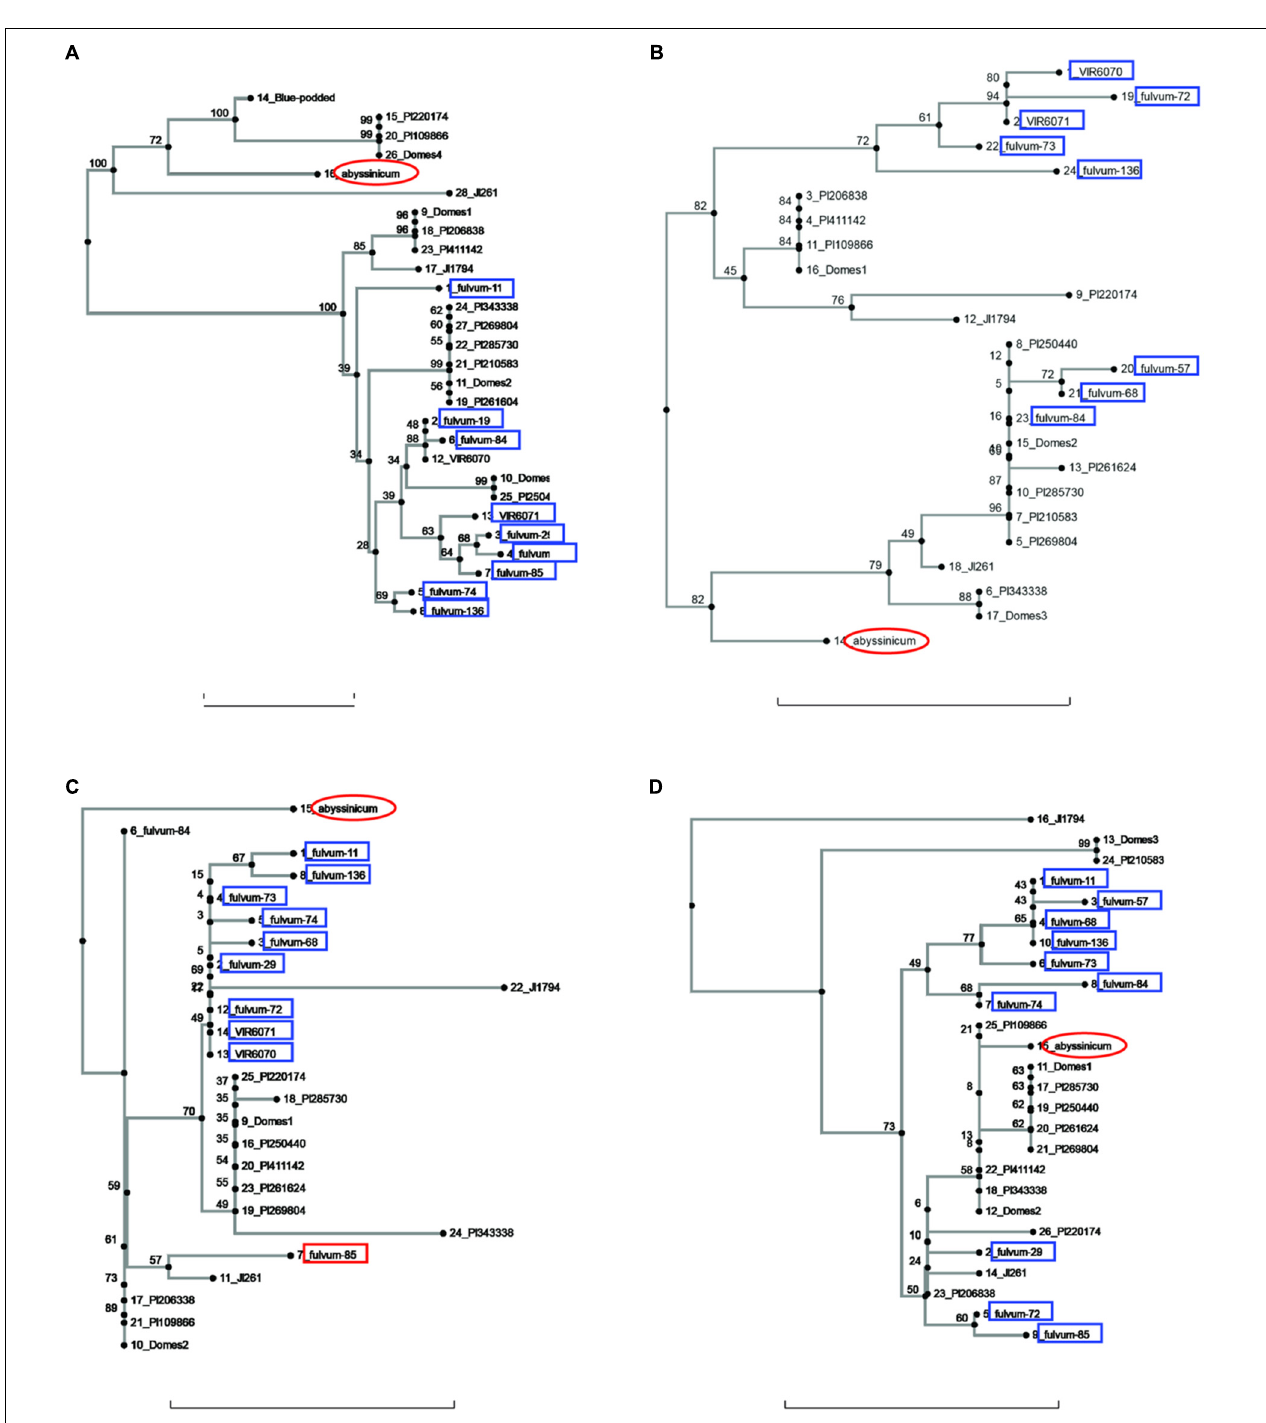
FIGURE 1 | Phylogeny trees of the alleles for (A) Pur , (B) R b , (C) GlyOH , and (D) Gpic . The position of the allele from P. sativum ssp. abyssinicum is circled in red, those for P. fulvum accessions are boxed in blue. The position of each PI accession is presented individually, but those for the modern varieties (except Blue-podded Shelling in (A) are lumped into groups labeled Domes1, Domes2, etc). Bar at base of each cladogram represents a nucleotide substitution rate of 0.01.